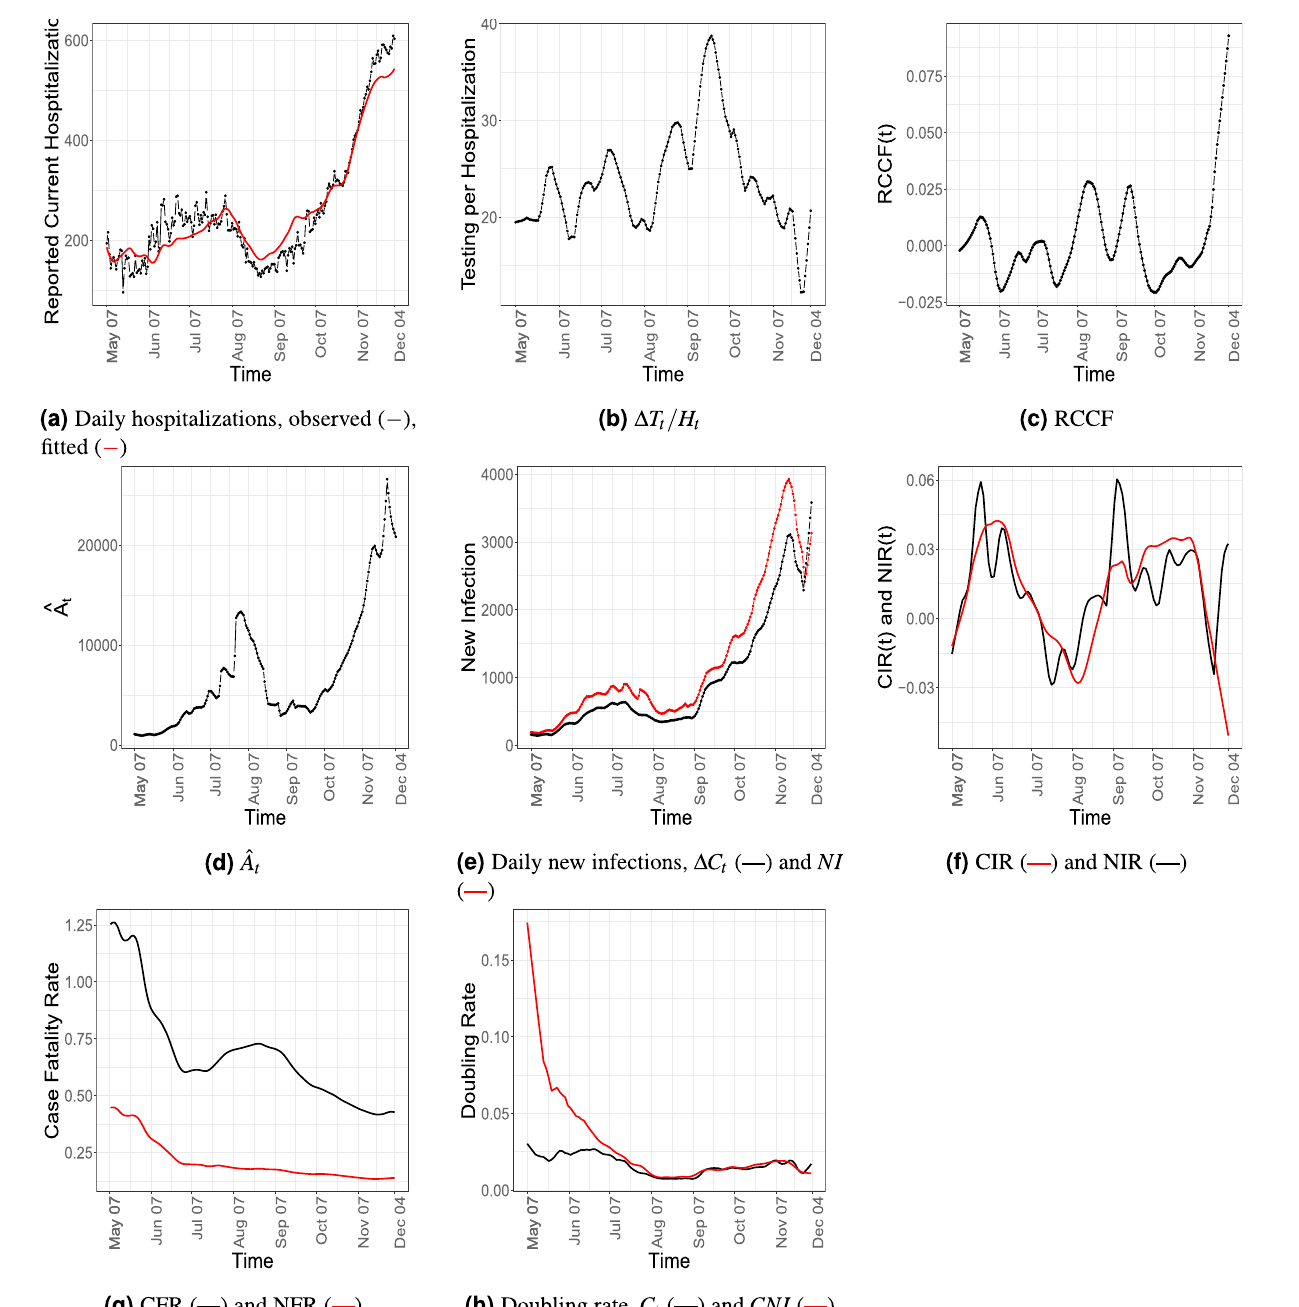
Figure 2. Temporal patterns of some compartments and epidemiological markers for